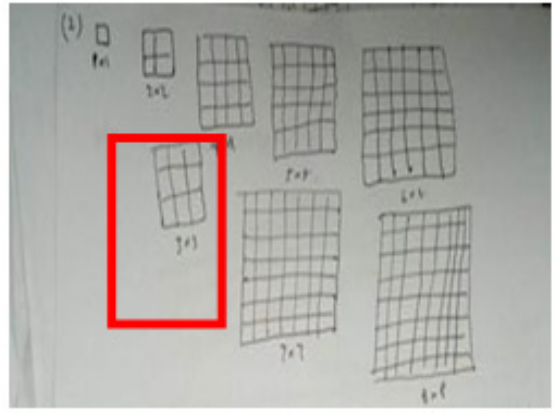
Figure 4. The Mathematics Anxiety In- dicator Experienced by S1 in Resolving Prob- lem